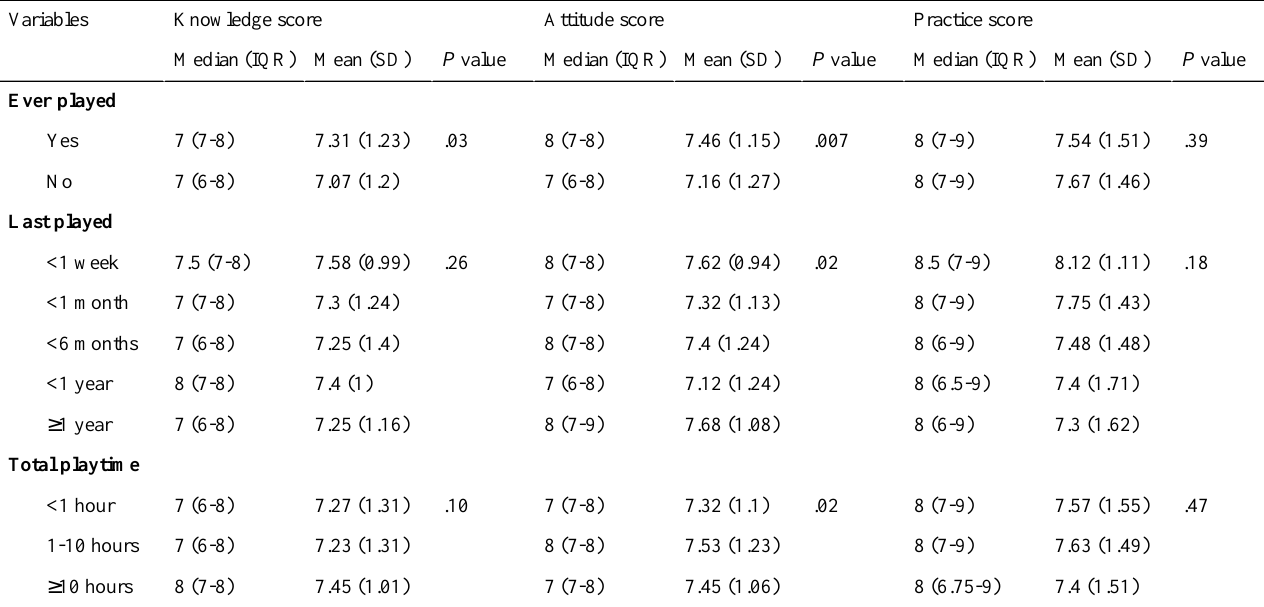
Table 5. Mann-Whitney U test and Kruskal-Wallis test for determining the effect of game experience on knowledge, attitudes, and practices regarding COVID-19 (N=276).